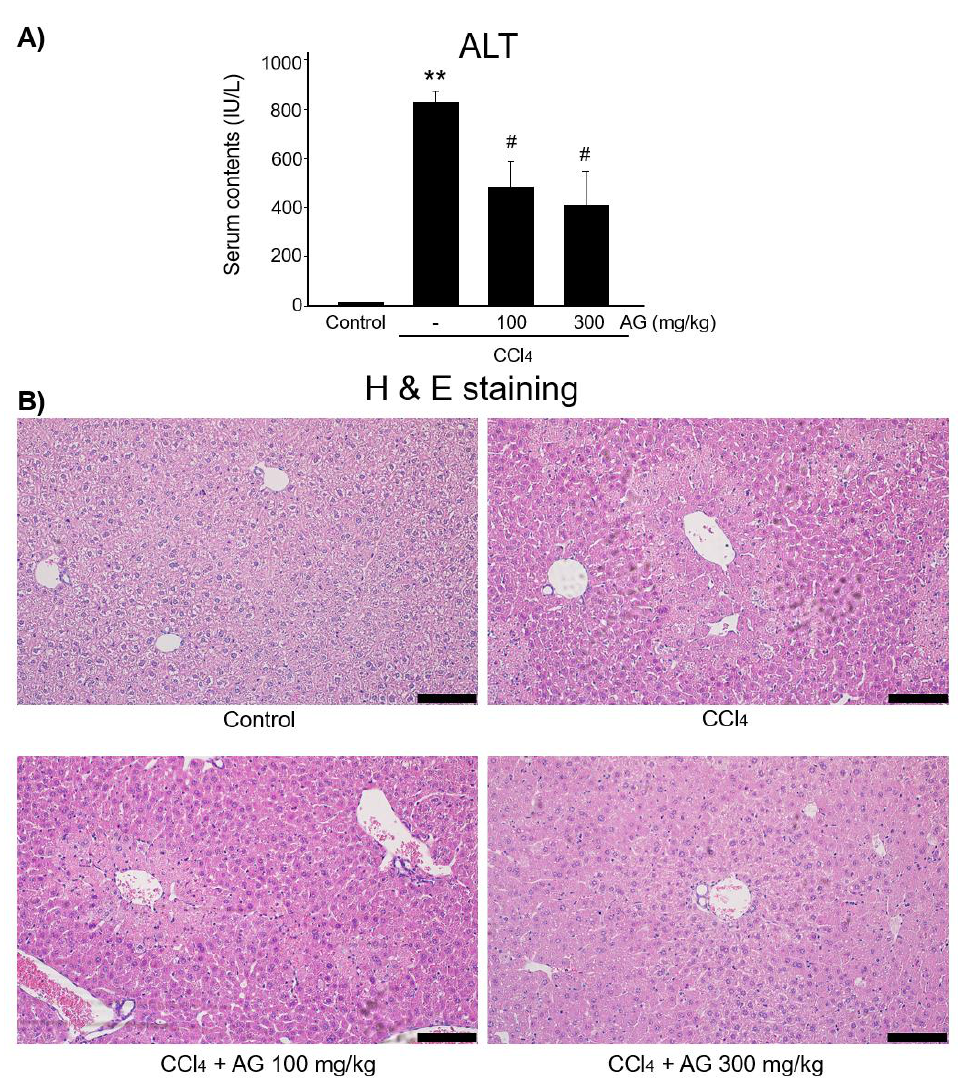
Figure 7. Effect of AG in CCl 4 -induced liver toxicity model. ( A ) Serum ALT level. ( B ) H&E staining. Mice were treated orally with 100 mg/kg or 300 mg/kg of AG. (** p < 0.01 vs. control group; # p < 0.05 vs. CCl 4 -treated group) Scale bar = 100 μ m, AG, Angelica gigas NAKAI